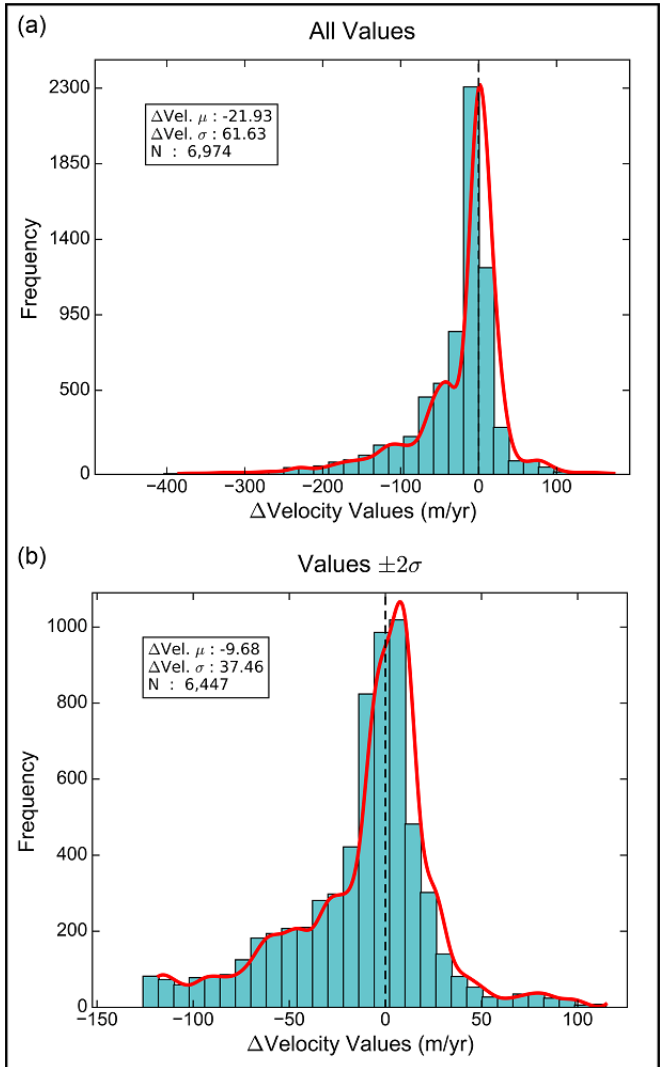
Figure 11. ( a ) Frequency histogram of all of the velocity differences. ( b ) Frequency histogram of just those differences that fall within ± 2 σ of the mean. The widths of the bars do change when the new frequencies are